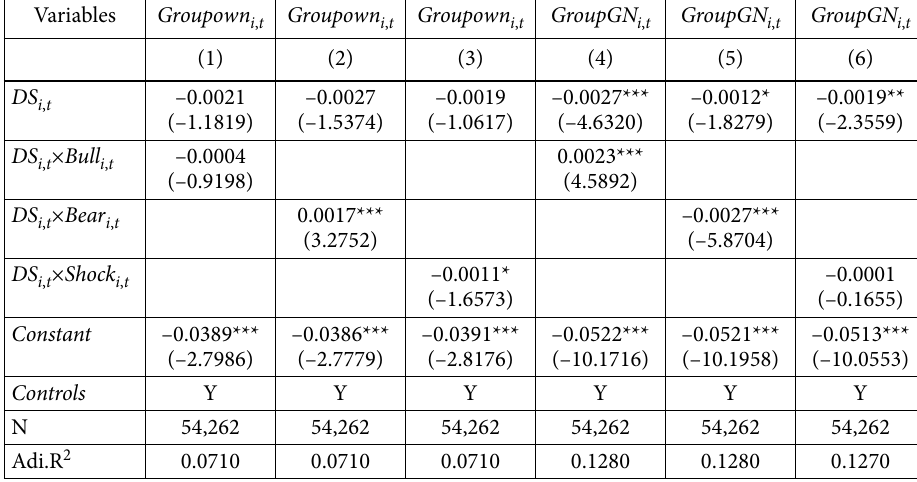
Table 9. Moderating role of market state – asymmetries in strategy deviation of firms and institutional investor recognition